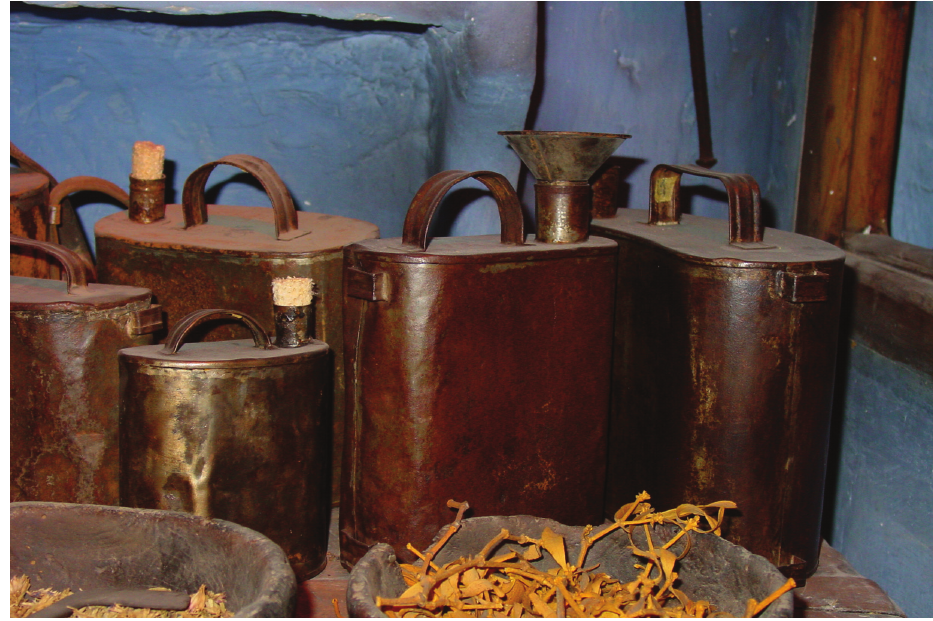
Figure 3: Llaunes ( llauna , sing.) Containers for transporting the remedies © Museu de les Trementinaires, Tuixent, Lleida,